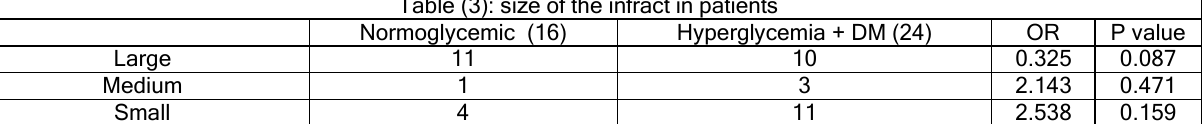
Table (3): size of the infract in patients